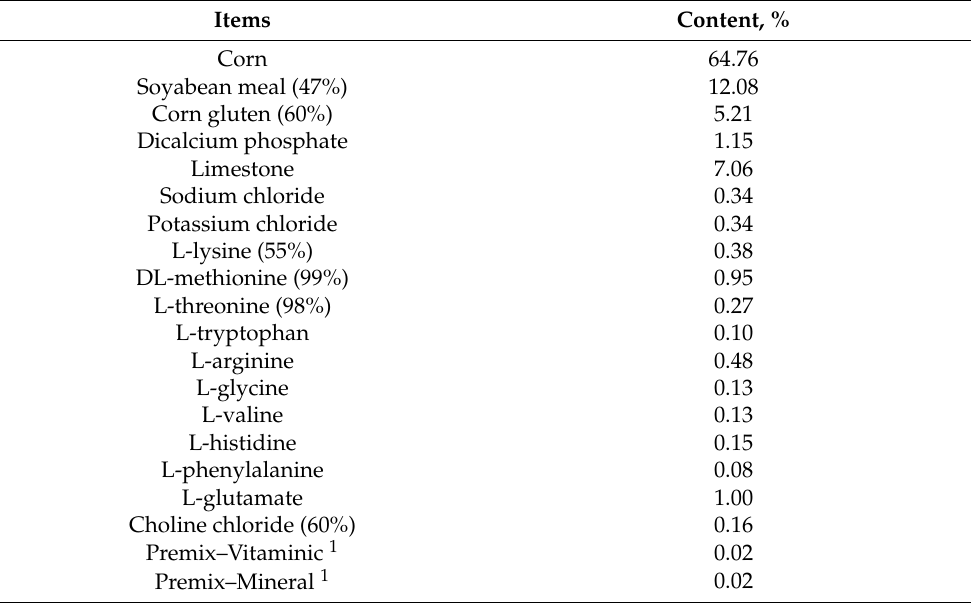
Table 3. Composition of the control diet (balanced protein).